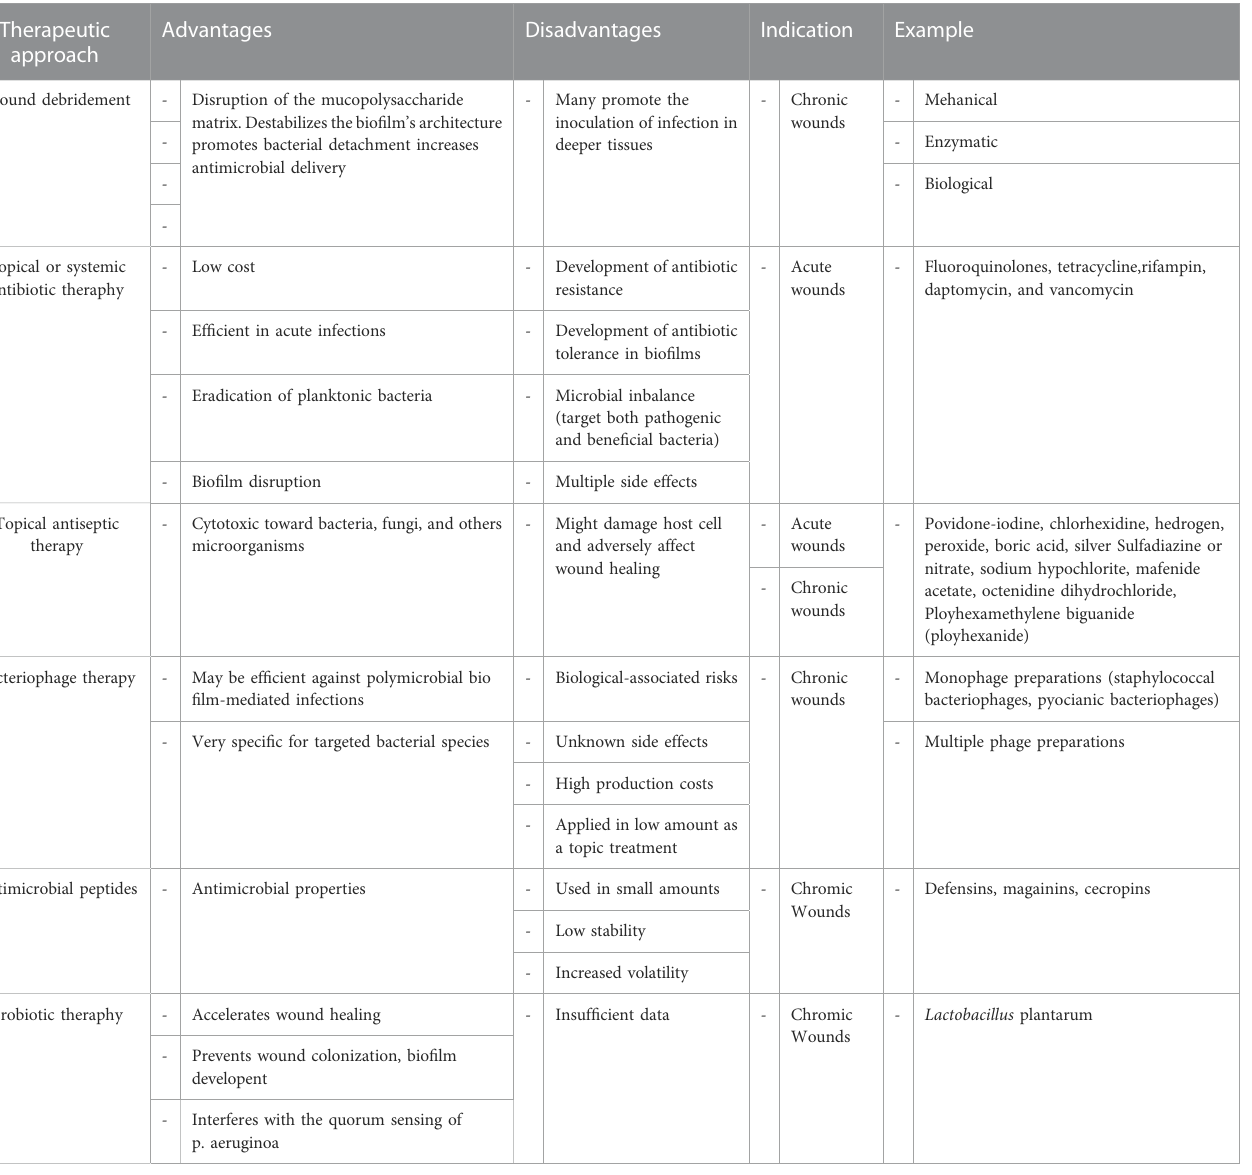
TABLE 1 Wound therapy approaches (Mihai, et al.,